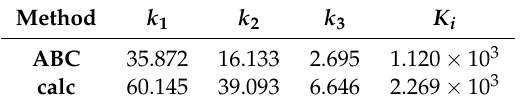
Table 4. Comparison of coefficients of SFC obtained by the ABC algorithm and calculated analytically